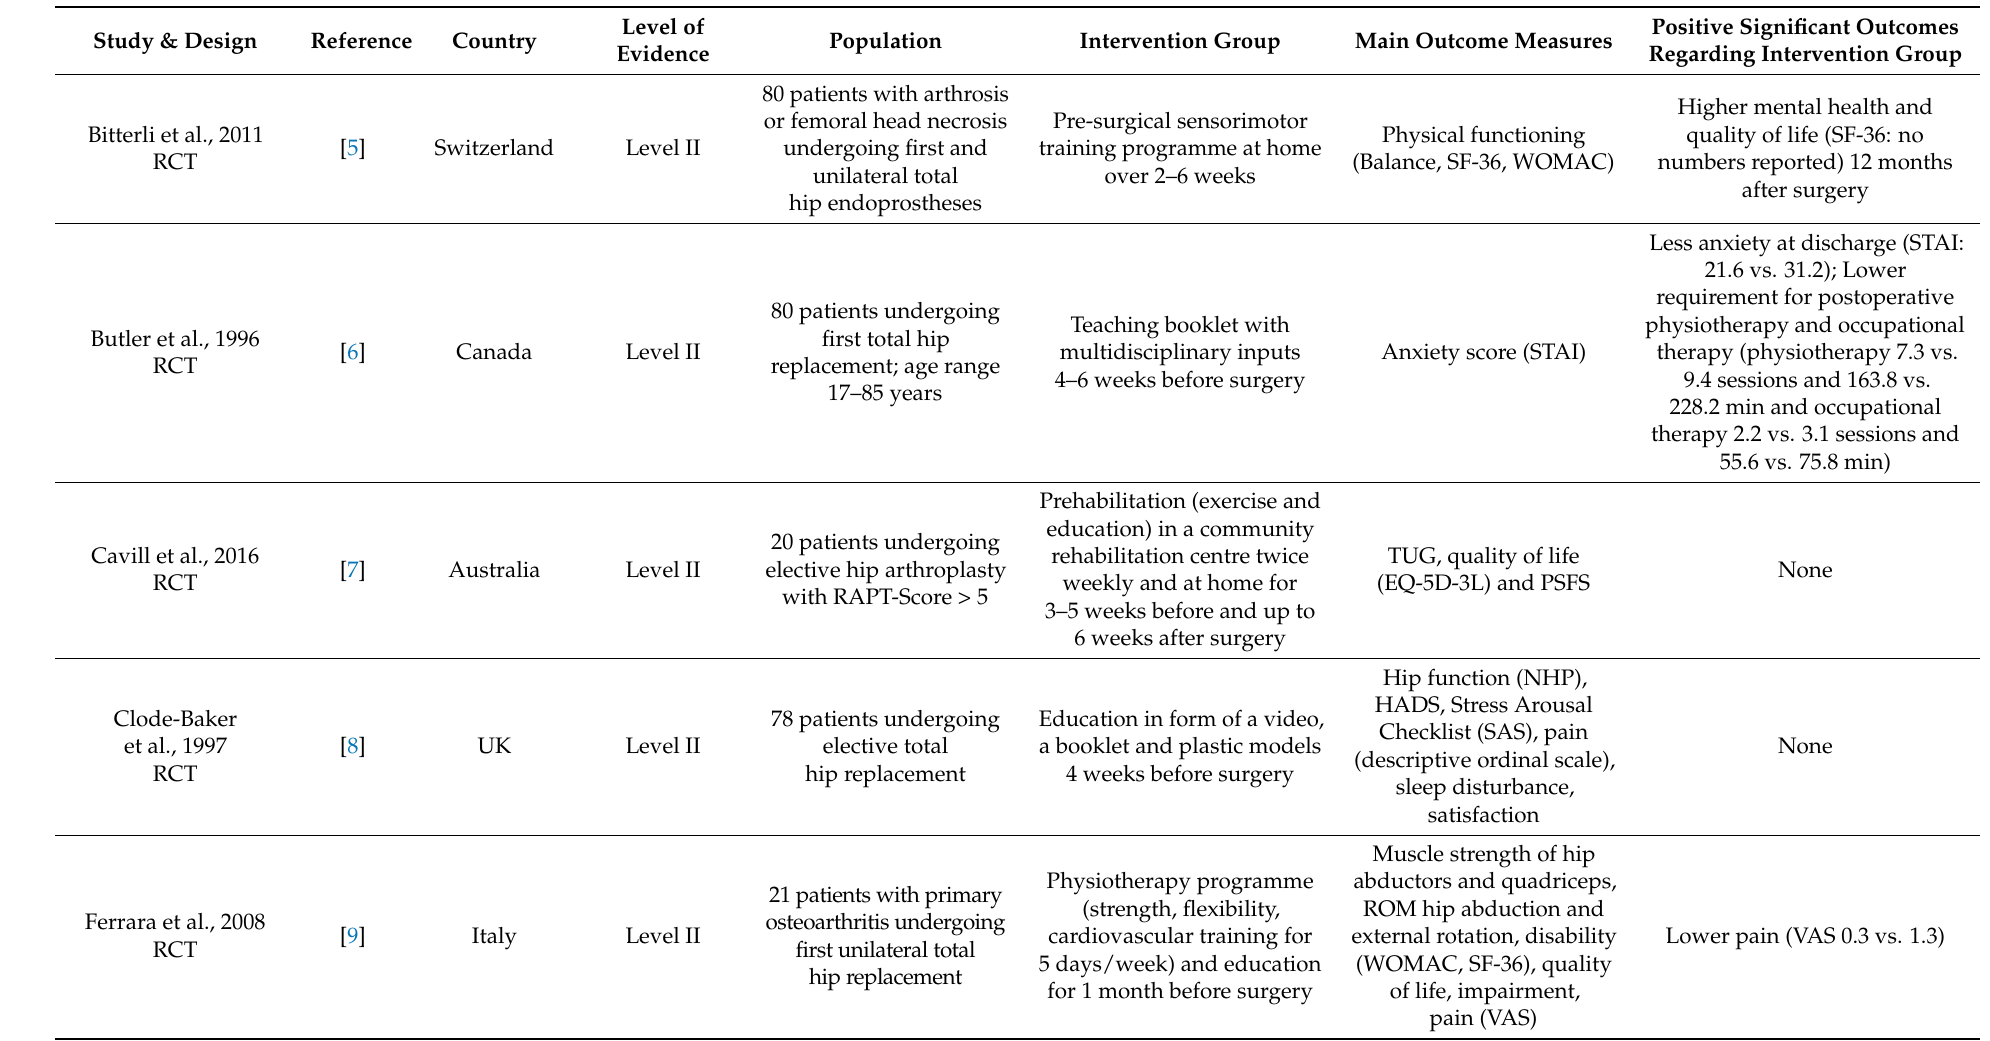
Table 1. Characteristics of included